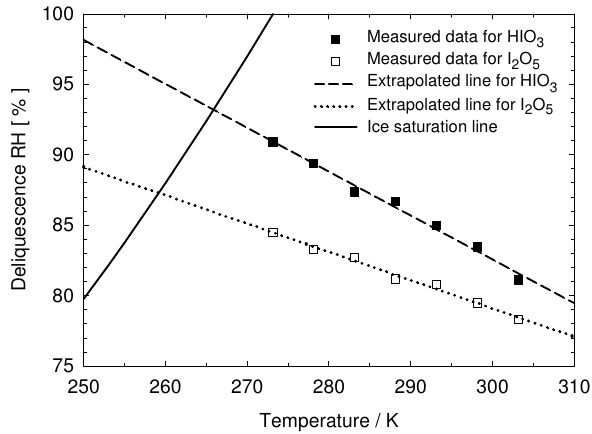
Fig. 10. Extrapolation of DRH fits of HIO 3 and I 2 O 5 to lower tem- peratures. The solid line is the ice saturation line while dashed and dotted lines indicate the extrapolation of DRH data of HIO 3 and I 2 O 5 respectively. The ice saturation line is determined from the ratio (multiplied by 100 to convert to %) of p ice to p liq using the expressions (equations 7 and 10) given in Murphy and Koop (2005).